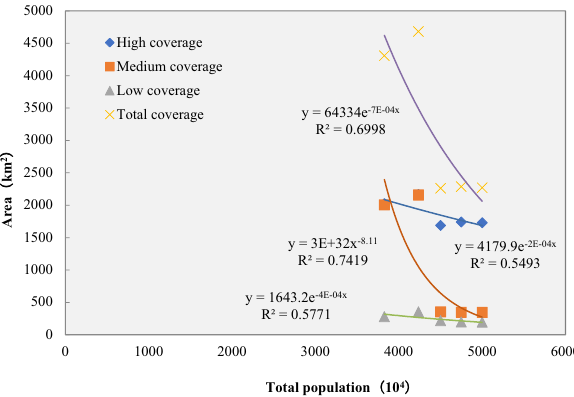
Figure 3. The relationship between grassland coverage area and total population.